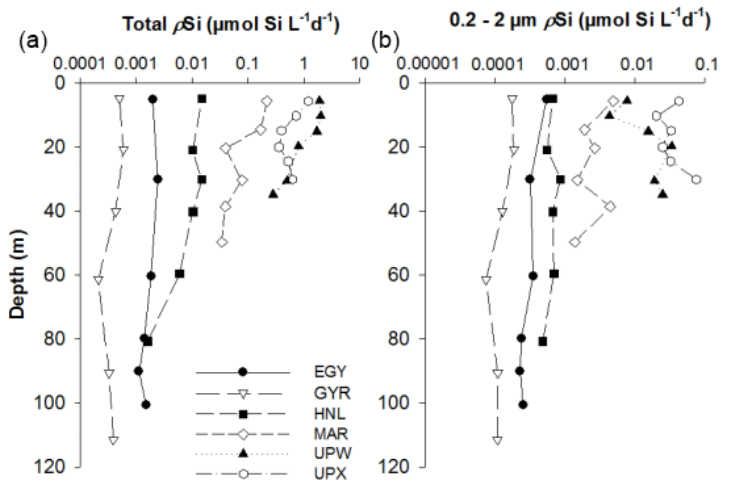
Figure 7. (a) Total absolute Si uptake rates ( ρ Si) vertical profiles (in µmolL − 1 d − 1 ) at the LD stations MAR, HNL, GYR, EGY, UPX and UPW. (b) ρ Si in the 0.2–2µm size fraction at the same sites. The x axis is in log scale to better show low production profile.